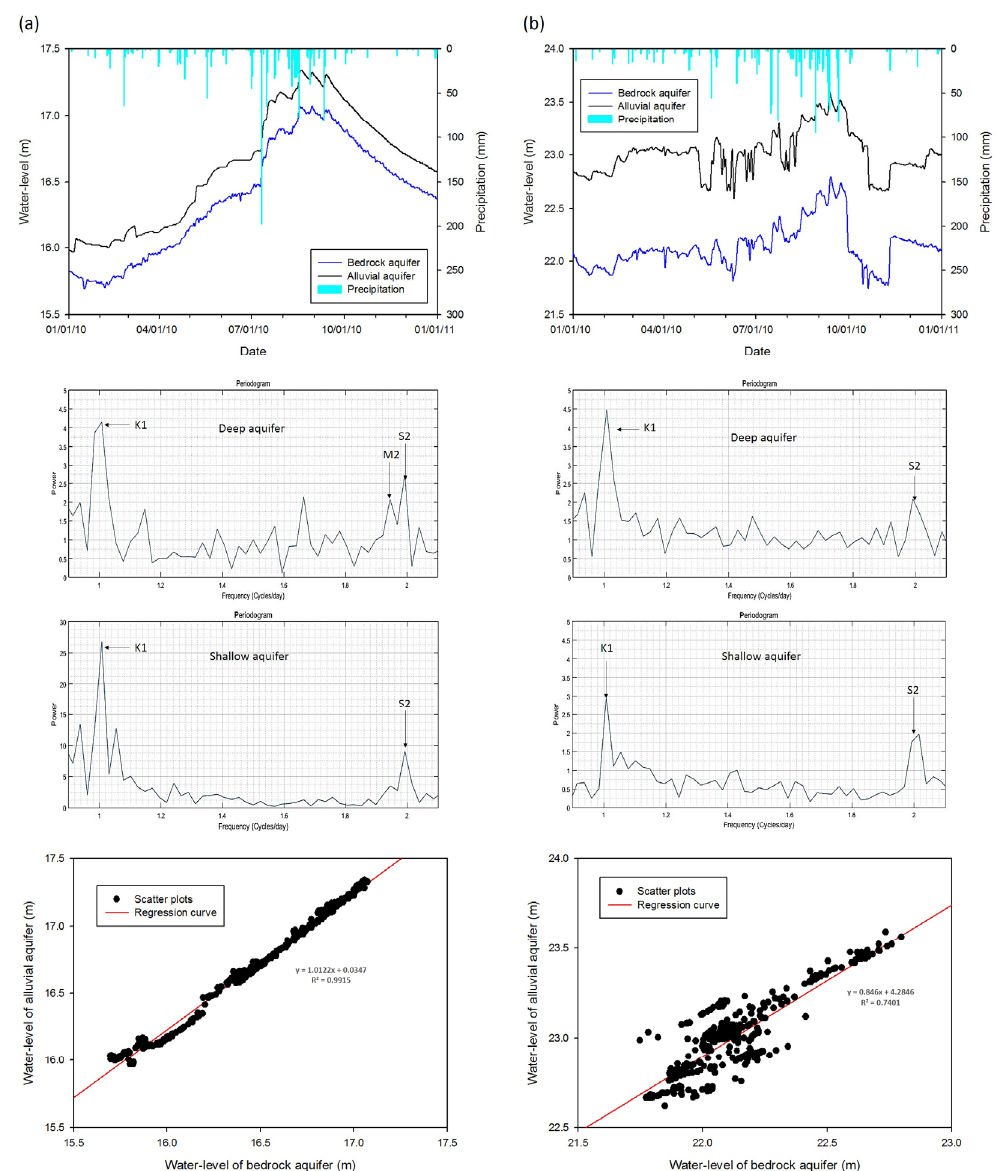
Figure 8. Results of the correlation analysis and harmonic analysis of the paired water-level data from shallow and deep monitoring wells in 2010 for Type III with unmatched aquifer system pairs and correlation coefficients: ( a ) the different aquifer characteristic but high correlation coefficient; and ( b ) the same aquifer characteristic but low correlation coefficient.